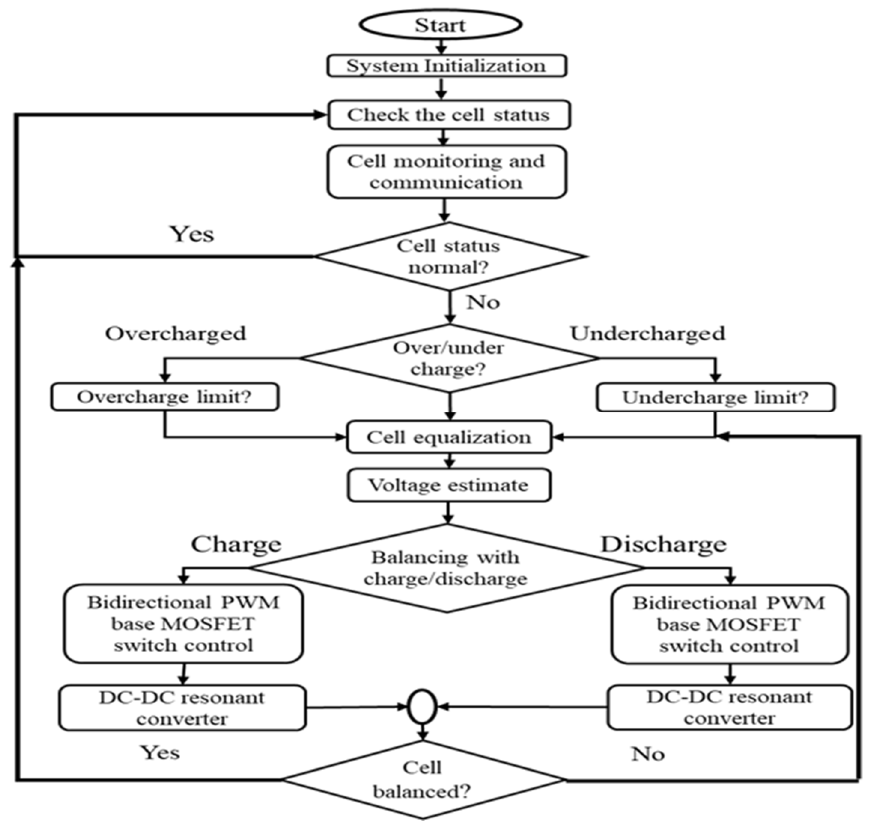
Figure 6. Flowchart of the proposed charge equalization algorithm. Algorithm 1 Proposed Charge Balancing